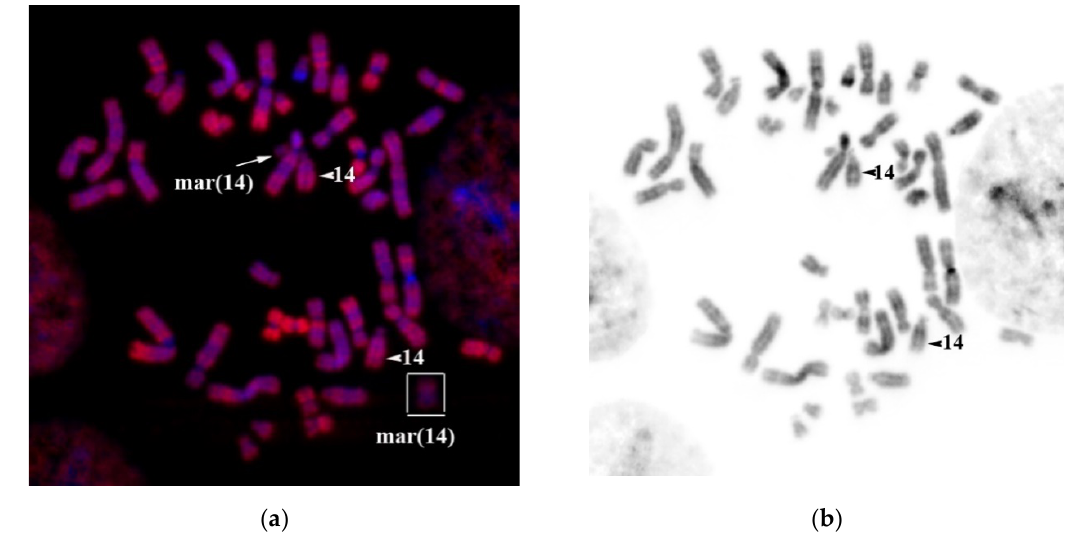
Figure 15. FISH ( a ) Alu-DNA probe on the patient’s metaphase chromosomes (red). On the right—marker chromosome labeled with a DNA probe detecting euchromatin. Chromosome 14 and the sSMC are indicated. ( b ) Inverted DAPI-banding. Chromatin DAPI staining is in blue. mar(14) and arrows indicate sSMC. Arrowhead indicates chromosome